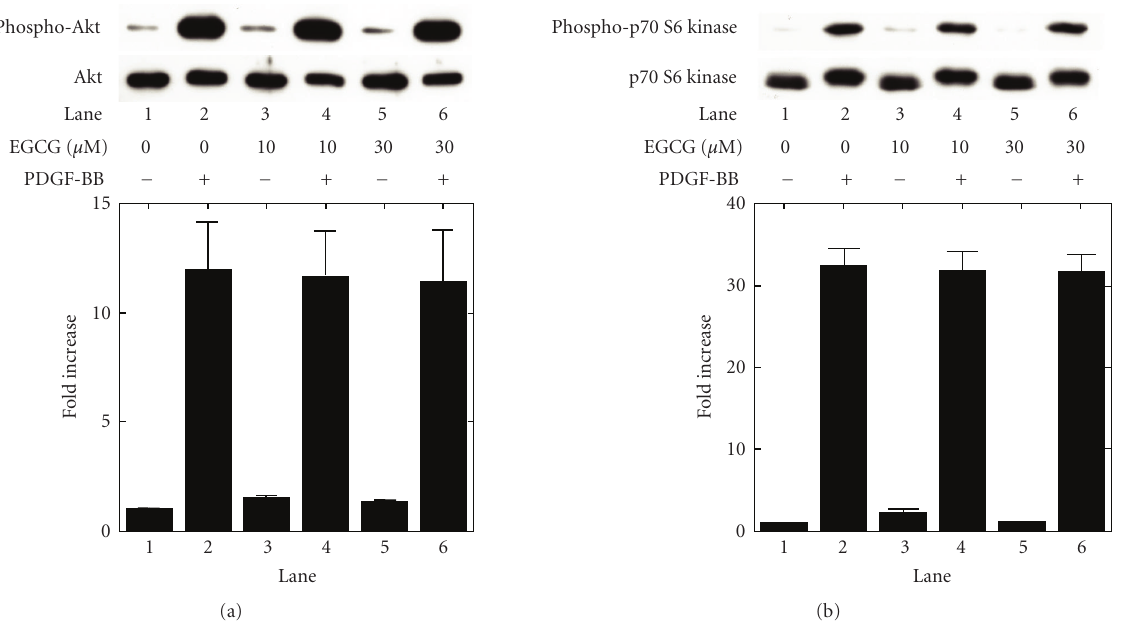
Figure 5: E ff ect of EGCG on the phosphorylation of Akt and p70 S6 kinase induced by PDGF-BB in MC3T3-E1 cells. The cultured cells were pretreated with the indicated doses of EGCG or vehicle for 60 minutes, and then stimulated by 50ng/mL PDGF-BB or vehicle for 20 minutes. The extracts of cells were subjected to SDS-PAGE with subsequent Western blotting analysis with antibodies against (a) phospho- specific Akt or Akt, and (b) phospho-specific p70 S6 kinase or p70 S6 kinase. The histogram shows quantitative representations of the levels of PDGF-BB-induced phosphorylation obtained from laser densitometric analysis of three independent experiments. Each value represents the mean ± SEM of triplicate determinations. Similar results were obtained with two additional and di ff erent cell